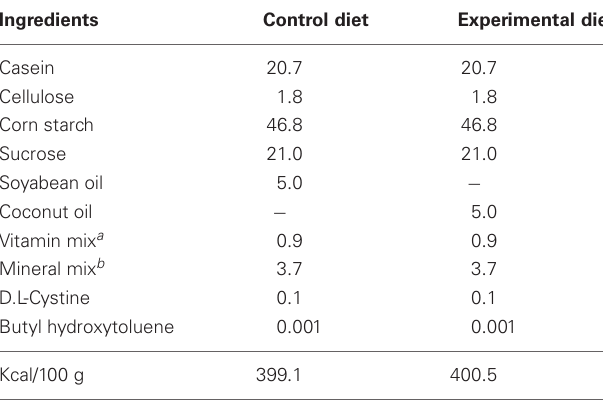
Table 1 | Diet composition (grams/100g